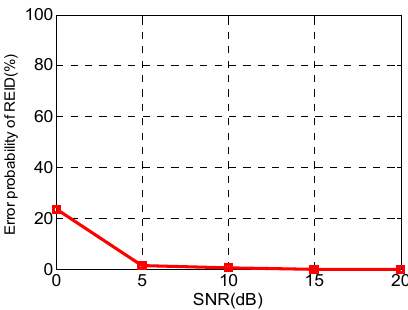
Figure 9. Error probability of REID by using SMR in different SNRs.